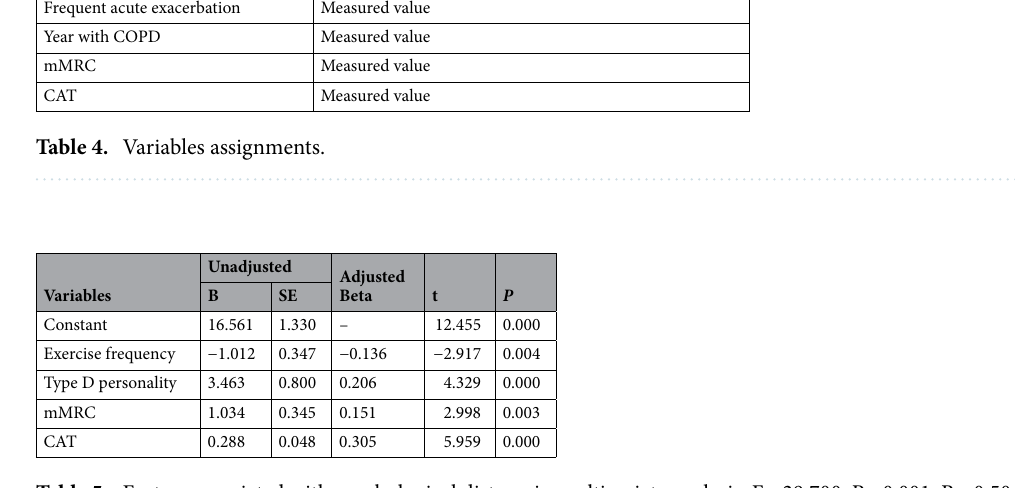
Table 5. Factors associated with psychological distress in multivariate analysis. F = 29.700, P < 0.001, R = 0.506, R 2 =